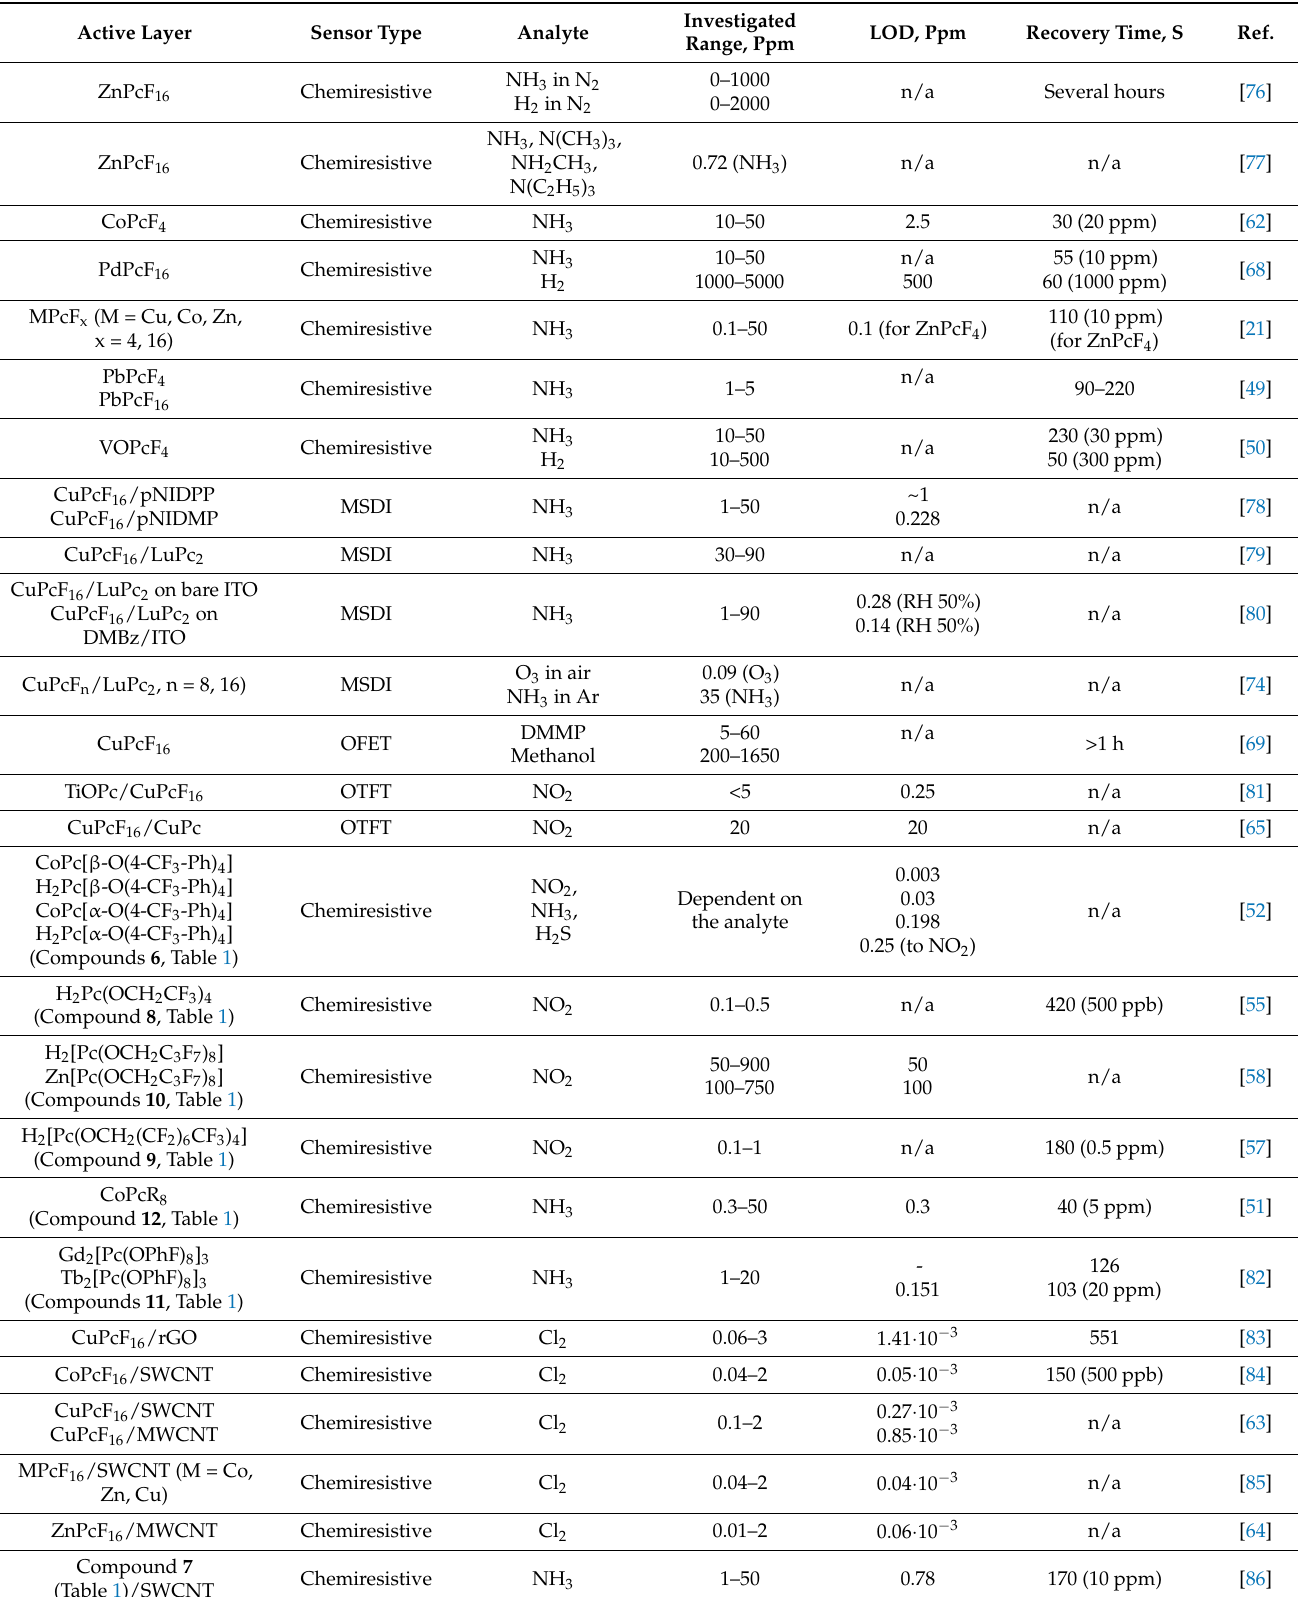
Table 2. Main characteristics of sensors on the basis of fluorinated metal